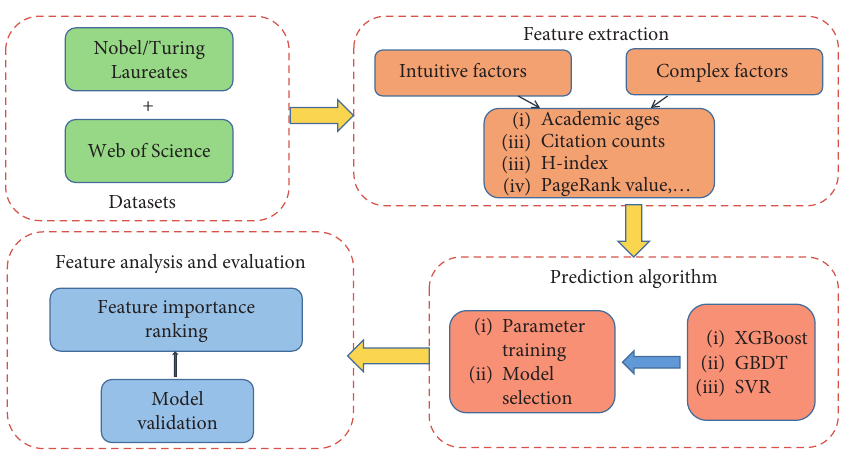
Figure 1: Architecture of the proposed